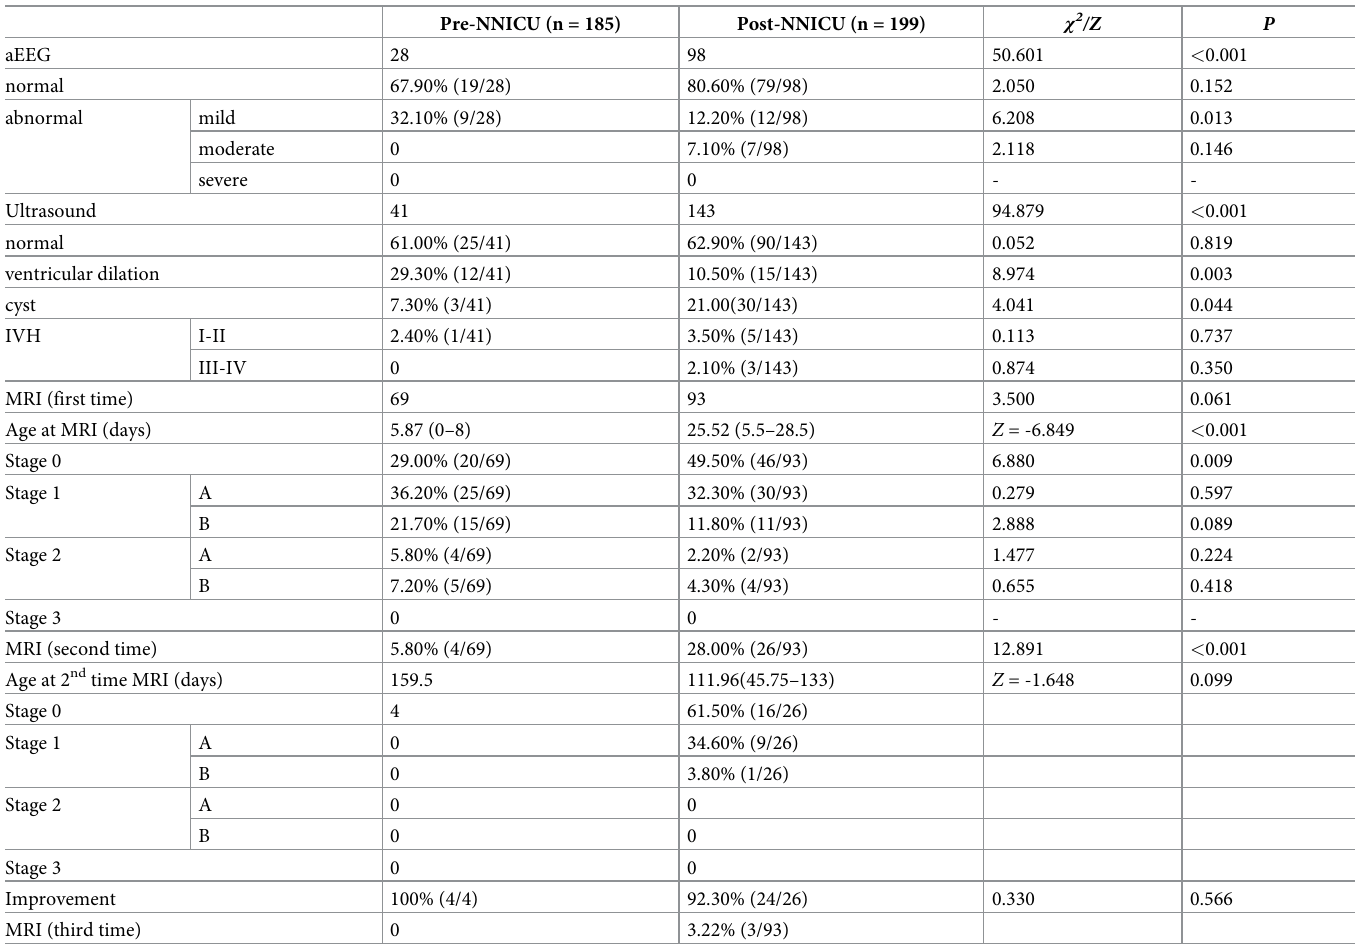
Table 3. Neuromonitoring and neuroimaging of the